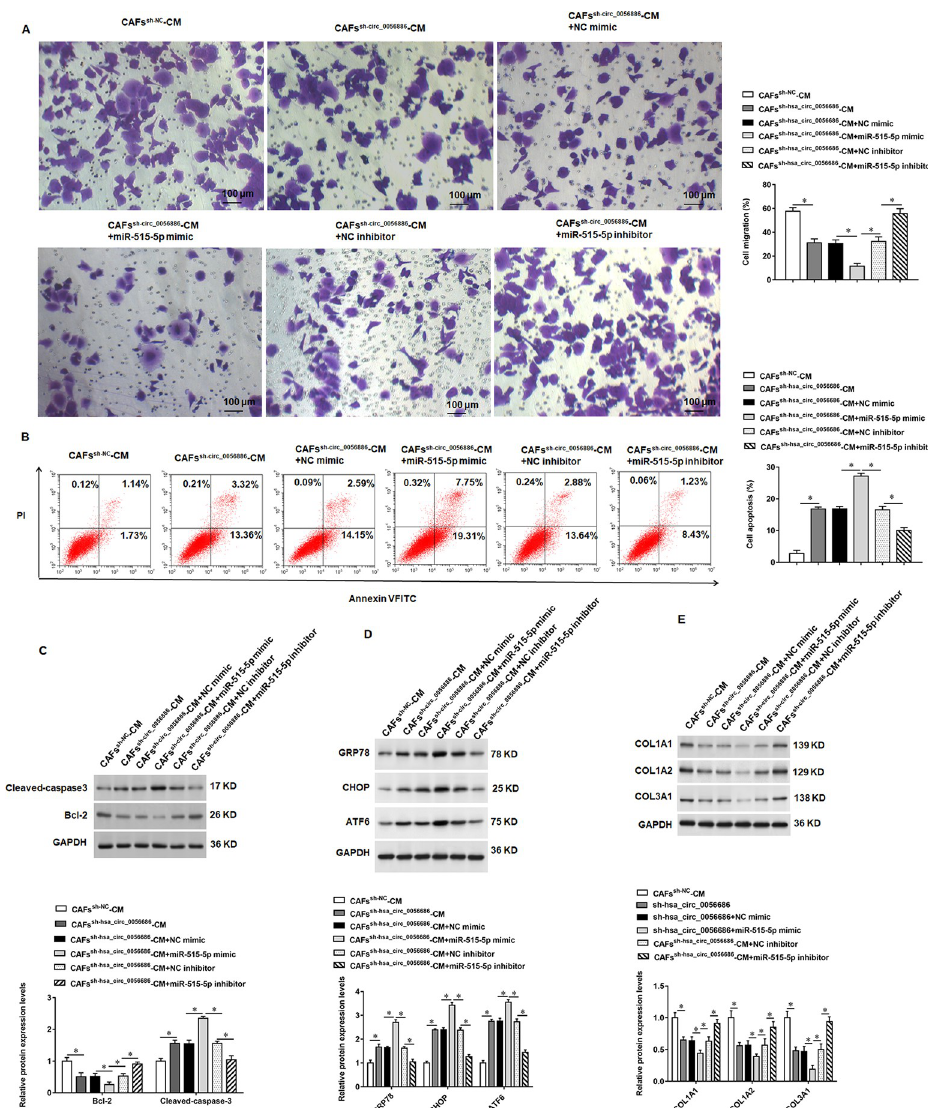
Fig 7. Hsa_circ_0056686 exerted the tumor-promoting ability of CAFs by directly targeting miR-515-5p. CAFs sh- circ_0056686 -CM treated LSMCs were transfected with miR-515-5p mimic or miR-515-5p inhibitor, respectively. (A) The migration ability of LSMCs was detected by Transwell assay. (B) The apoptosis ratio of LSMCs was detected by flow cytometry assay. (C) The expression of apoptosis-related proteins Cleaved-caspase3 and Bcl-2 was examined. (D) The expression of ERS-related proteins GRP78, CHOP and ATF6 was examined. (E) The expression of ECM-related proteins COL1A1, COL1A2 and COL3A1 was examined. � P < 0.05, vs CAFs sh-NC -CM or CAFs sh-NC -CM + NC mimic.